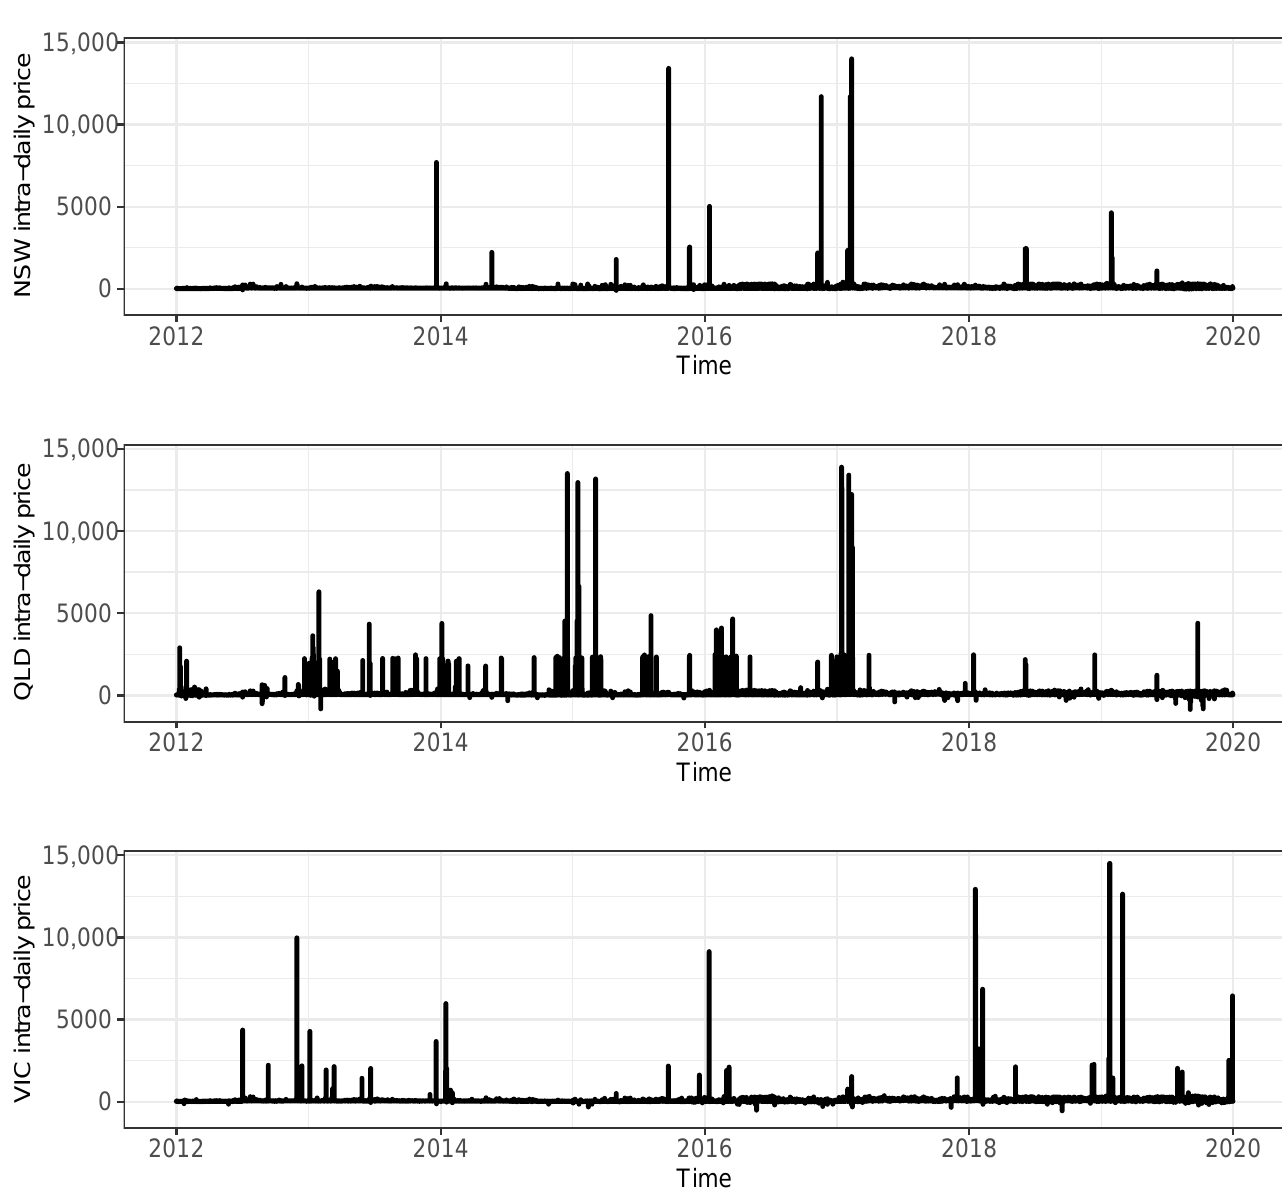
Figure 1. 30-min intradaily prices. Time series of 30-min electricity spot prices for NSW ( top ), QLD ( middle ), and VIC ( bottom ). The sample period is from 1 January 2012 to 31 December